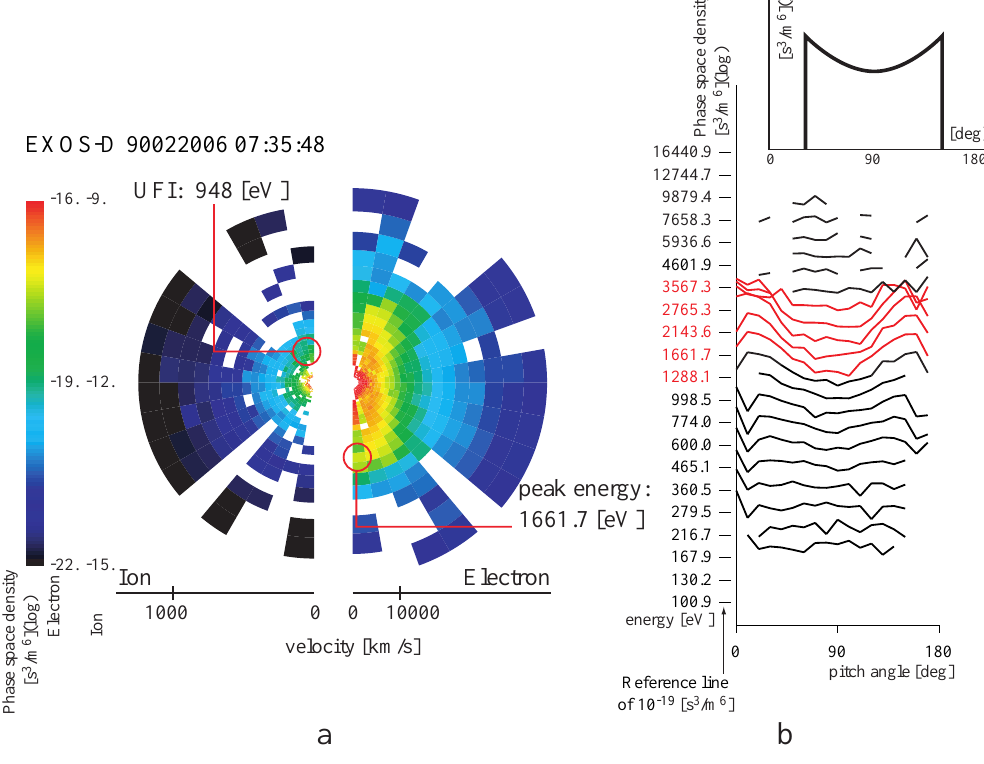
Fig. 11. Distribution of electrons and ions observed by Akebono. (a) Distribution function of electrons and ions, respectively, in the velocity space. The electron’s distribution function shows a “cylindrical” distribution. (b) Up: Schematic model pitch angle distribution function by Eq. (11). Bottom: Pitch angle distributions of electrons at different